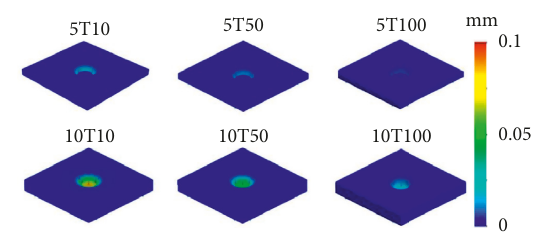
Figure 6: 3D simulation of